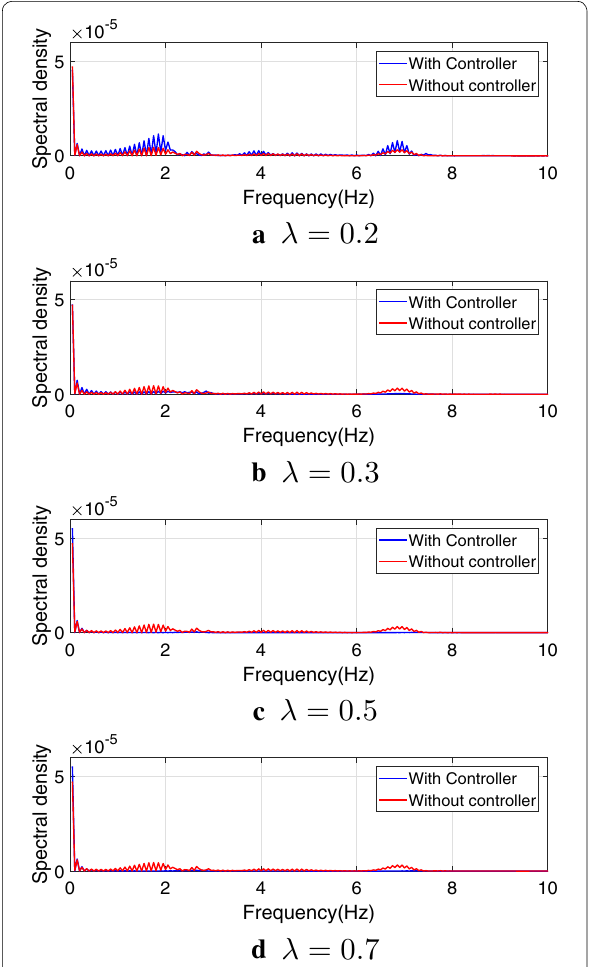
Fig. 15 Strain power spectral density for varying (cid:31) , link 1 in-plane